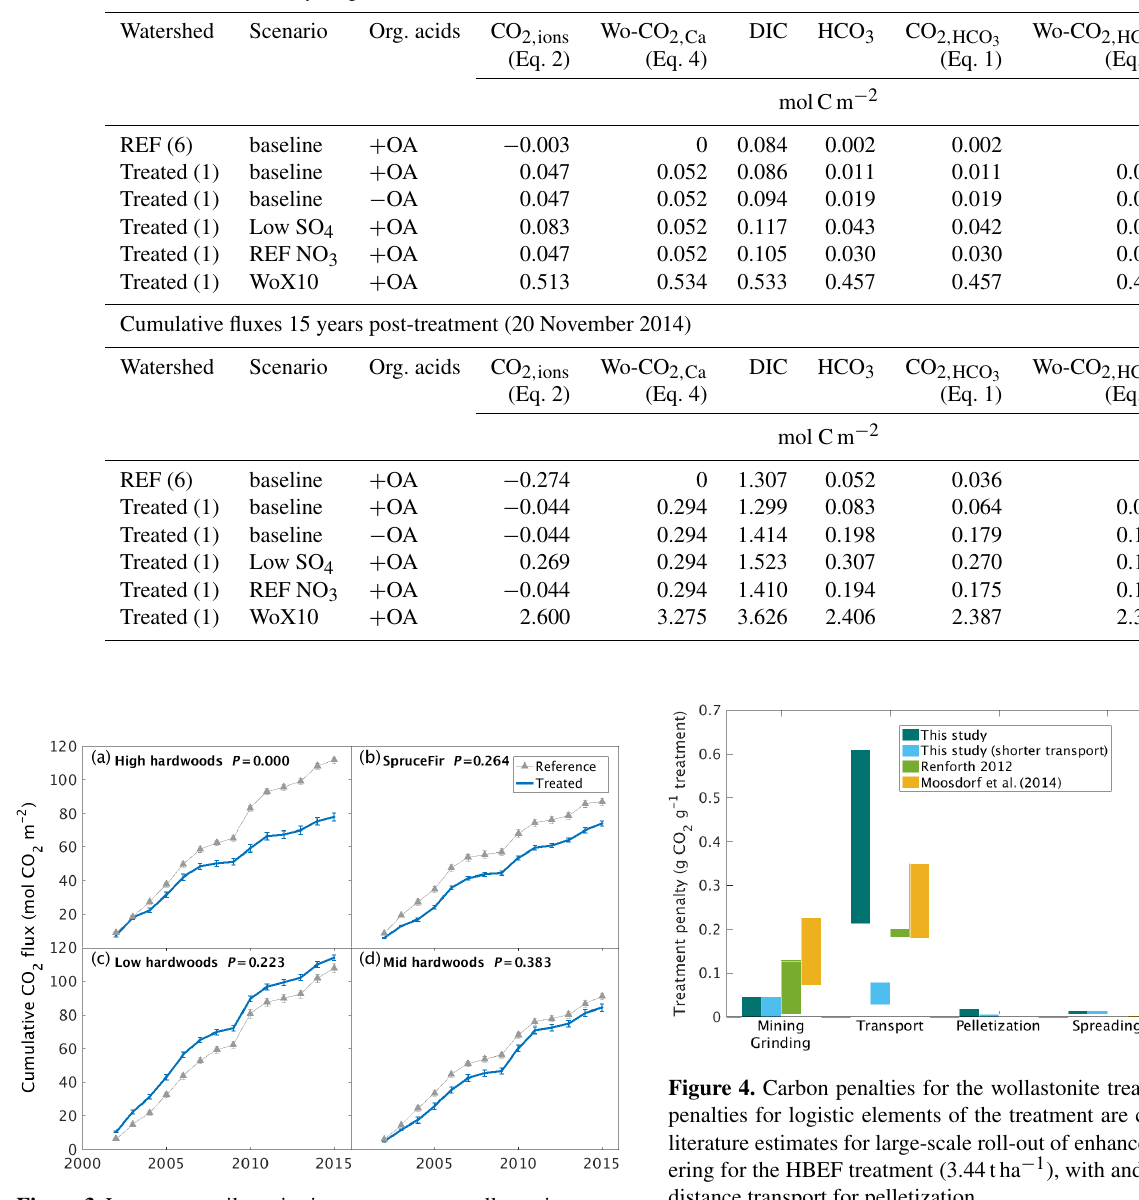
Figure 3. Long-term soil respiration responses to wollastonite treat- ment at Hubbard Brook Experimental Forest. Cumulative soil CO 2 respiration responses of treated and untreated (a) high-elevation hardwoods, (b) high-elevation conifers, (c) low-elevation hard- woods, or (d) mid-elevation hardwoods. Plots show cumulative means ± 1 SE for three chamber measurements at each site and time. Reference data were collected from untreated forests immediately adjacent to the western edge of our reference catchment. P values from Kruskal–Wallis tests comparing treated and reference raw data (Supplement) are shown.